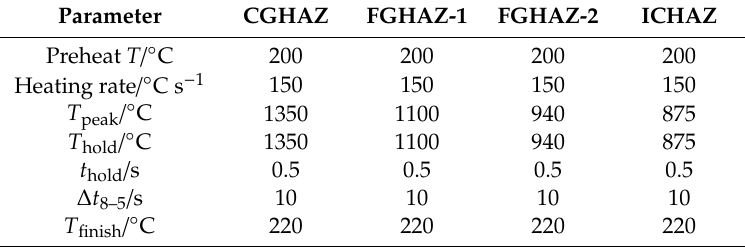
Table 3. Parameters for HAZs material preparation in a weld thermal cycle simulator. Parameter